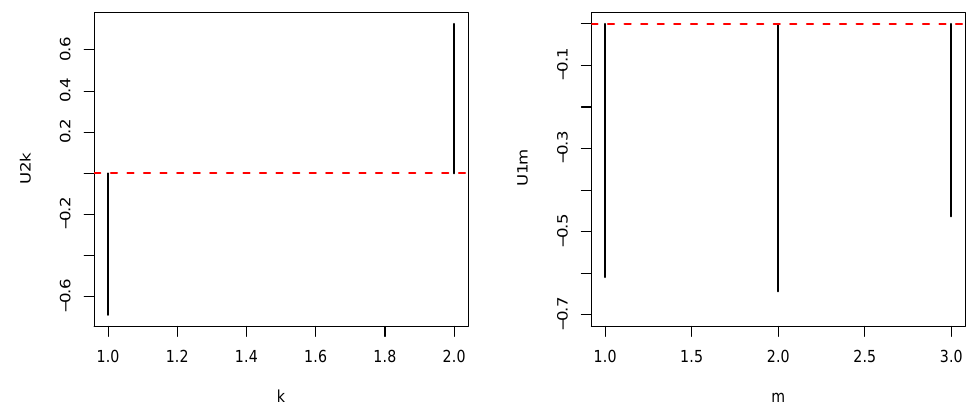
Figure 5. u 2 k and u 1 m when HOSVD is applied to the real